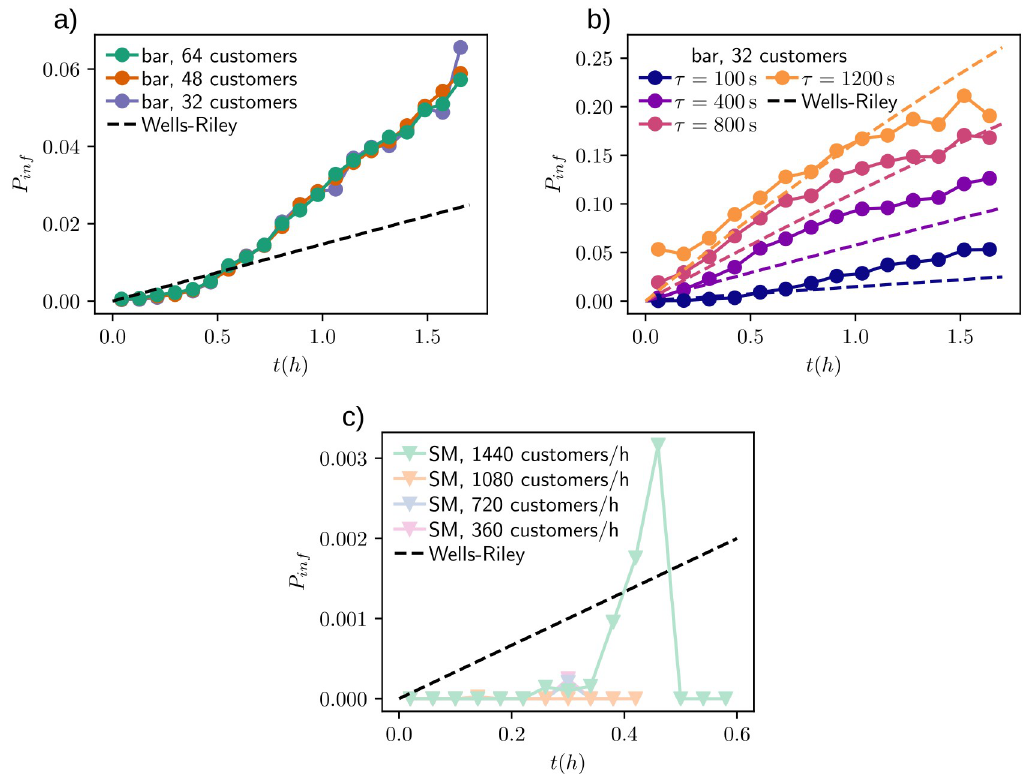
Fig 5. Approximate infection risk for healthy customers in (a) bar simulations with different customer densities, (b) bar simulations with varying ventilation (parameter τ ) and (c) supermarket simulations with time t spent in the system with single infected customer. The infection probability in our simulations is estimated as the proportion of customers with N > N Comparison of simulation results to Wells-Riley equation is also included: the approximated value for quanta generation rate q = 25801/h is derived in the text, and the ventilation rate Q is calculated according to corresponding τ and Eq